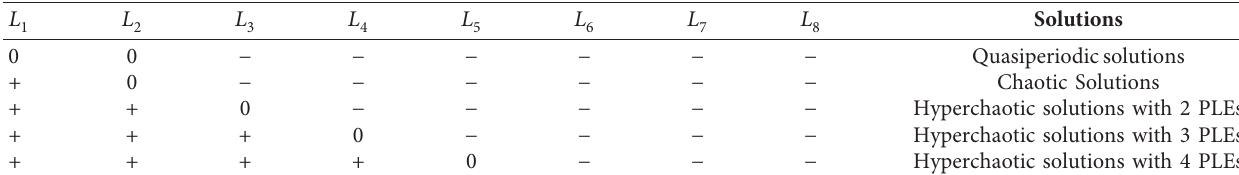
Table 1: Dynamics of system (2).